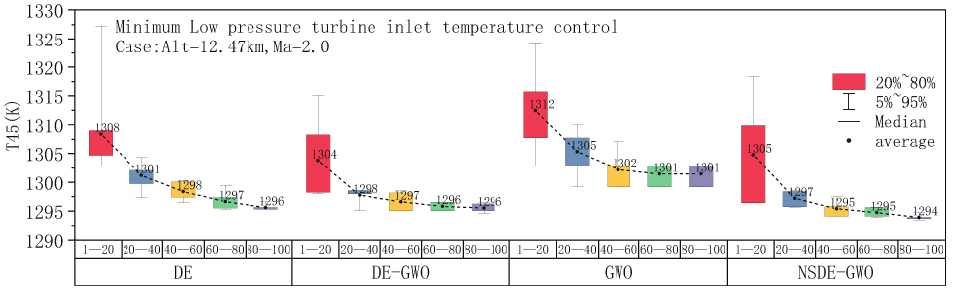
Figure 10. Box plots of different iterative algorithm optimization process in minimum low-turbine inlet temperature control